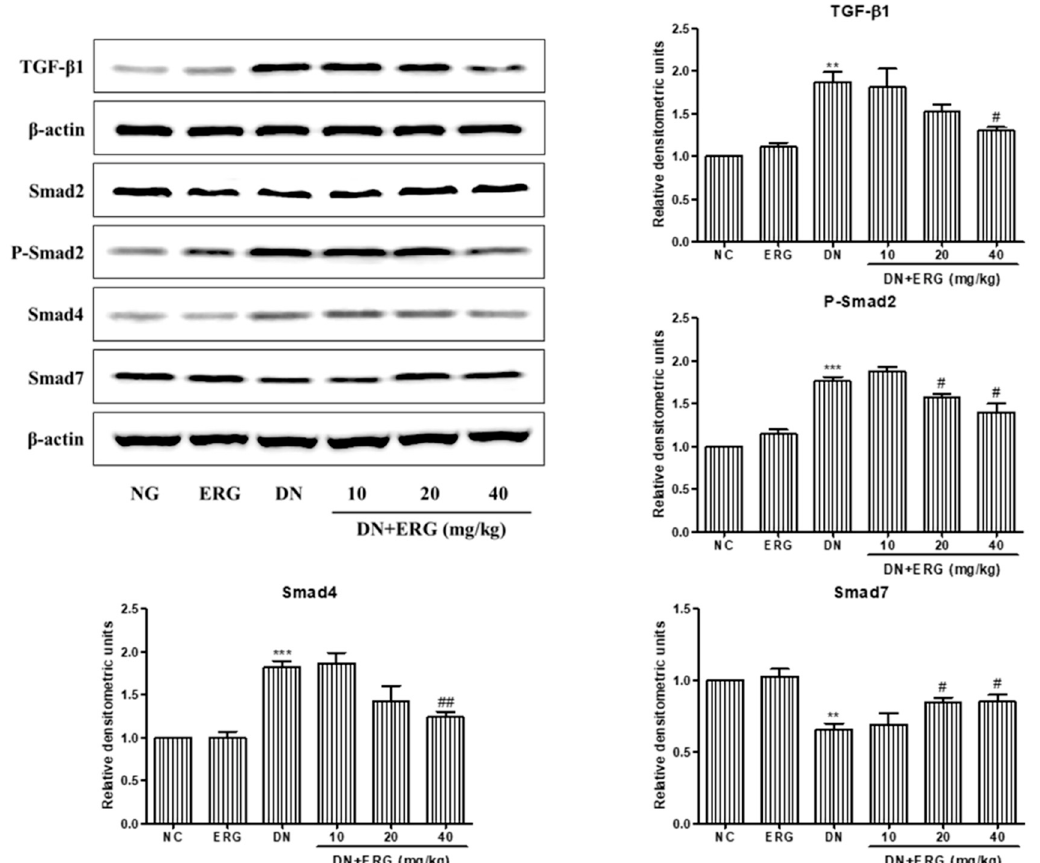
Figure 6. Ergosterol inhibited the renal transforming growth factor- β 1 (TGF- β 1)/ drosophila mothers against decapentaplegic 2 (Smad2) signaling pathway in STZ-induced diabetic mice. This figure shows these results of Western blot analysis of TGF- β 1, Smad2, phosphor-Smad2, Smad4, and Smad7. NC: normal control; DN: diabetic nephropathy model induced by STZ; ERG10, ERG20, ERG40: 10, 20, 40 mg/kg/day ergosterol administration. Data are presented as the means ± SD, n = 3. ** p < 0.01, *** p < 0.001 compared with NC; # p < 0.05, ## p < 0.001 compared with DN.